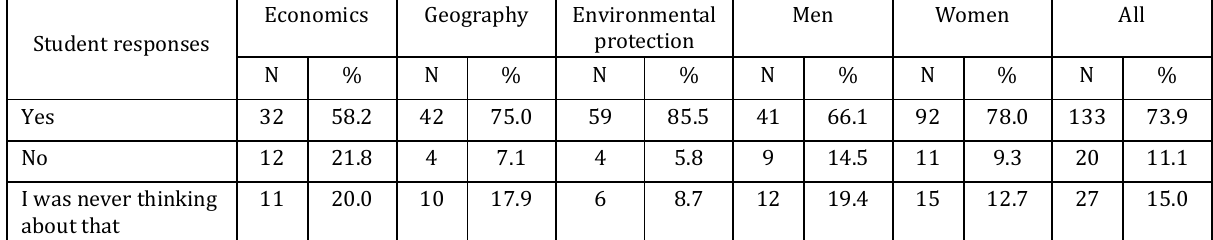
Table 7. The responses of the students to the question 12 - "Do you take specific steps to protect the environment in your everyday